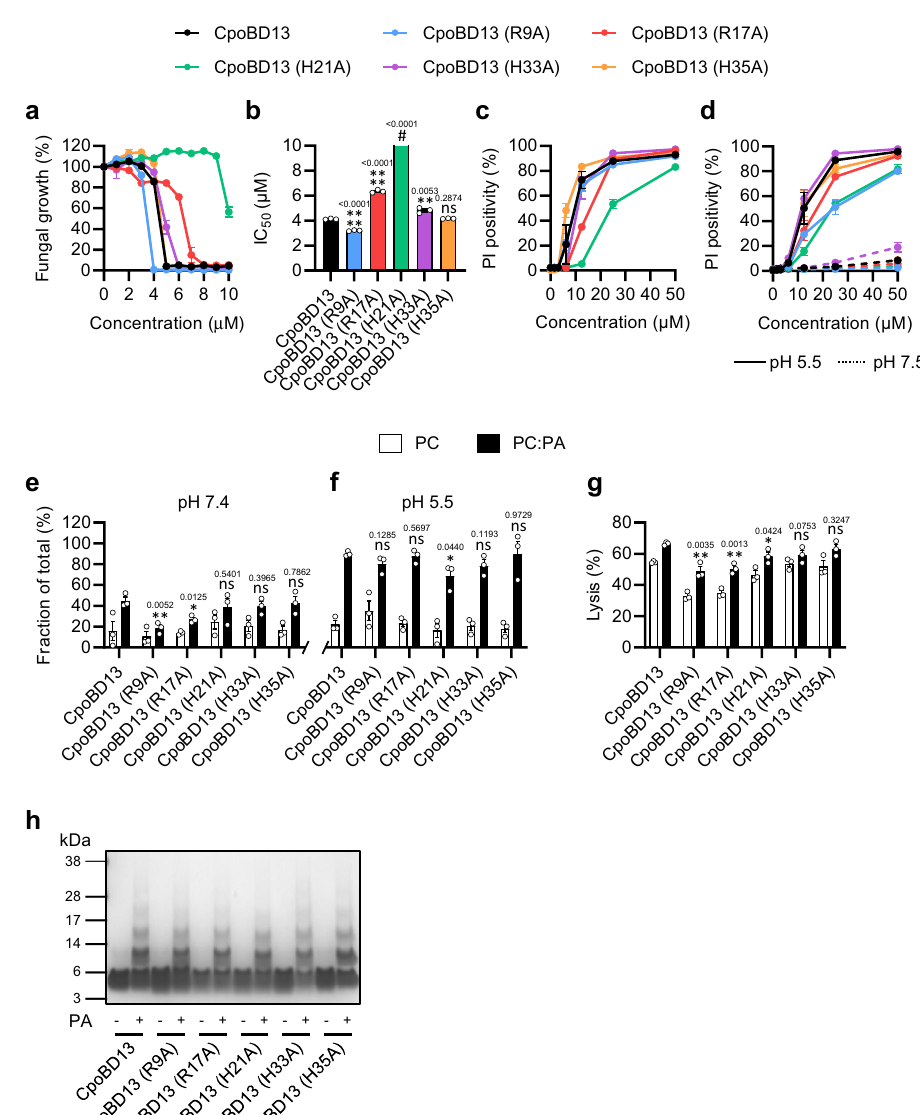
Fig. 4 | Structure – function analysis of the interaction between CpoBD13 and PA. Data represent ± SEM, n =3. All statistical evaluations are comparisons to the corresponding CpoBD13 wild type sample. ns, not signi fi cant, * P <0.05, ** P <0.01, **** P <0.0001 two-tailed unpaired t test. Exact P values are stated above their respective graphs. a Fungal growth inhibition of C. albicans treated with wild type ormutantCpoBD13over24h. b CalculatedIC 50 valuesofthefungalgrowthcurves. # The IC 50 of CpoBD13 (H21A) could not be determined within the assessed con- centration range (0 – 10 µ M). c Membrane permeabilisation of C. albicans treated with wild type or mutant CpoBD13 for 30min as determined by the uptake of PI. d Membrane permeabilisation of C. albicans in pH buffered conditions (pH 5.5 =